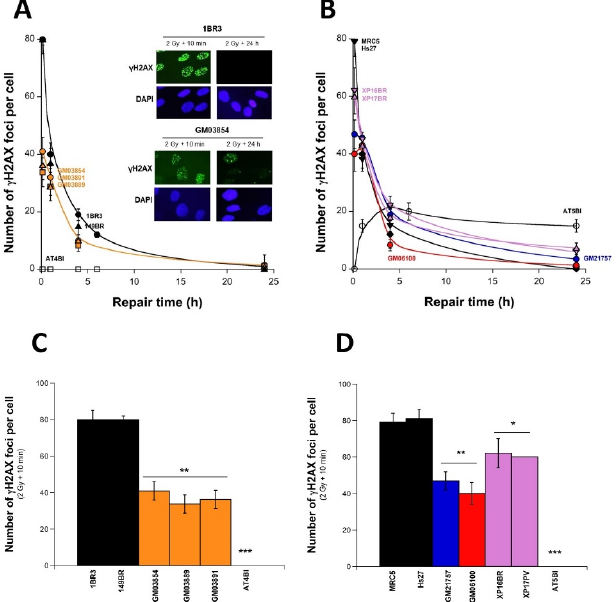
Figure 3. Kinetics of the appearance/disappearance of γ H2AX foci in USH1 fibroblasts: The number of γ H2AX foci was plotted against post-irradiation time. Data were obtained from the radioresistant controls 1BR3 and 149BR, the hyper-radiosensitive ATM -mutated AT4BI, and the three USH1 (GM03854, GM03889, and GM03891) fibroblast cell lines ( A ), and from the radioresistant controls MRC5 and Hs27, the hyper-radiosensitive ATM -mutated AT5BI, the HD (GM21757), the TSC (GM06100), and two XPD (XP16BR and XP17PV) fibroblast cell lines ( B ). Panels ( C , D ) represent the 10 min post-irradiation data only. Each plot represents the mean ± SEM of three replicates. Data were fitted to Bodgi’s formula [36]. The insert shows a representative illustration of DAPI-stained nuclei and γ H2AX foci observed at 10 min and 24 h post-irradiation (2 Gy X-rays) in the indicated cell lines. Asterisks represent statistically significant differences from radioresistant controls, expressed as p -values (1, 2, and 3 asterisks correspond to p < 0.05, p < 0.01, and p < 0.001,